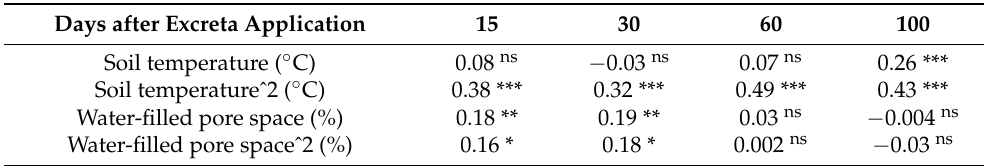
Table A4. Effect of sampling days on the relationships ( R 2 ) between N 2 O-N emission and environ- mental factors (soil temperature and water-filled pore